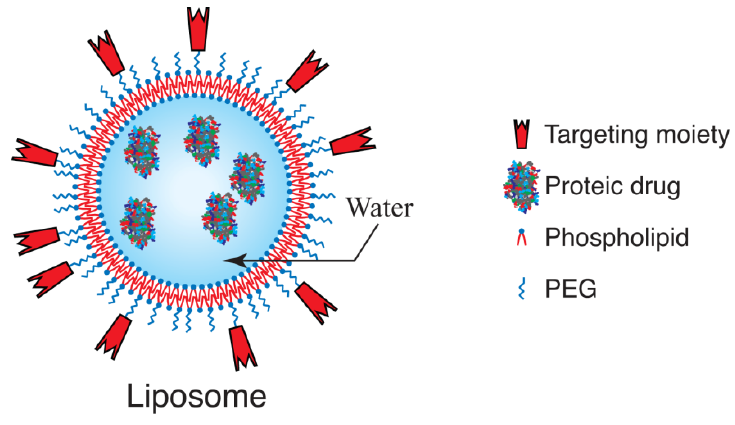
Figure 1. Structure of a unilamellar liposome for drug